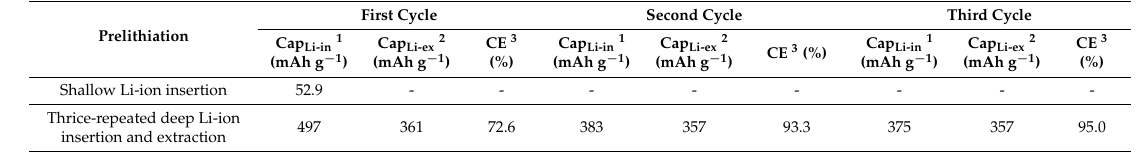
Table 1. Prelithiation processes to prepare the HC NEs used for the NCM/prelithiated HC full-cells. First Cycle Second Cycle Third Cycle Prelithiation Shallow Li-ion insertion 52.9 - - - - - - - - Thrice-repeated deep Li-ion insertion and extraction 497 361